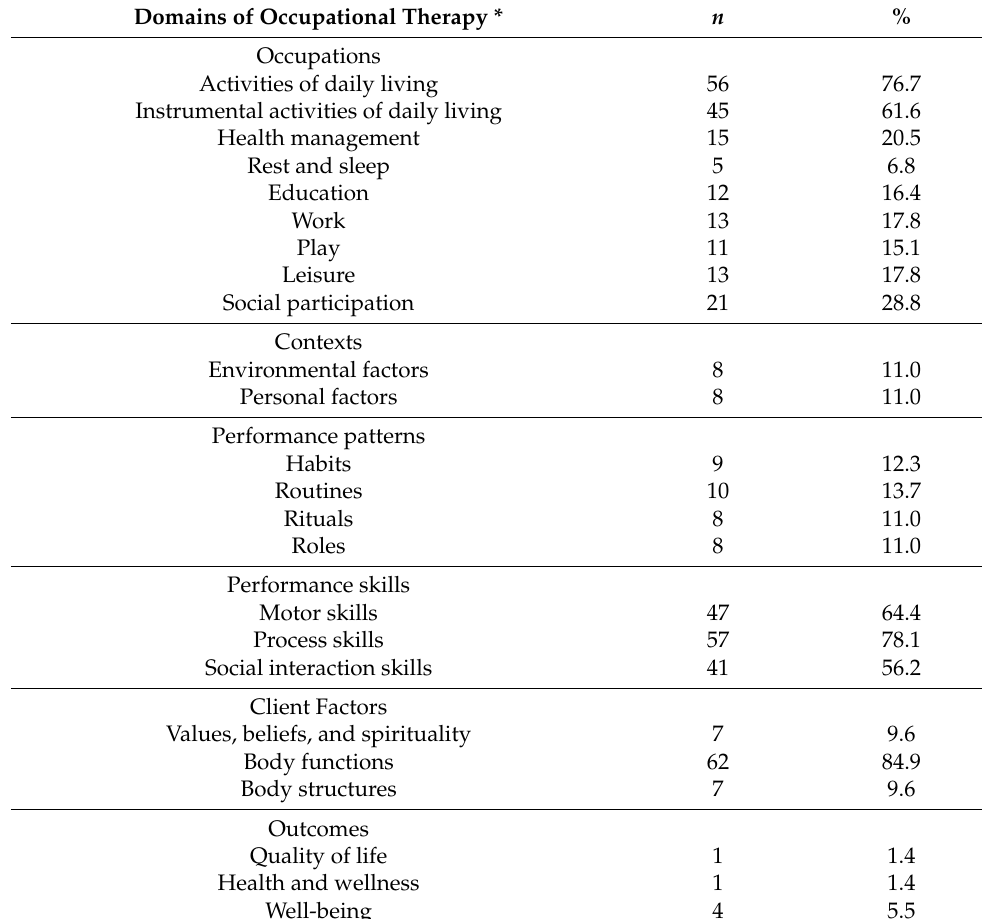
Table 2. Percentage use of 147 assessment tools reported by the participants according to the main domains of occupational therapy based on the Occupational Therapy Practice